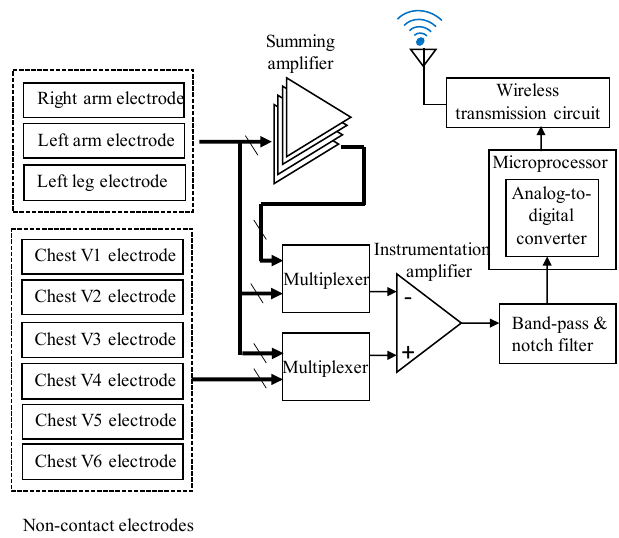
Figure 4. A block diagram of the wearable 12-Lead ECG acquisition module.